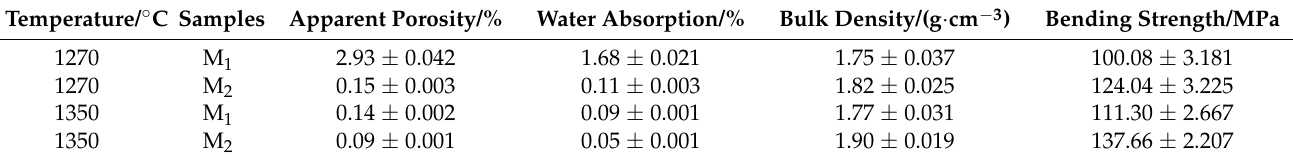
Table 2. Properties of porcelain raw materials with and without activated kaolinite sintered at different